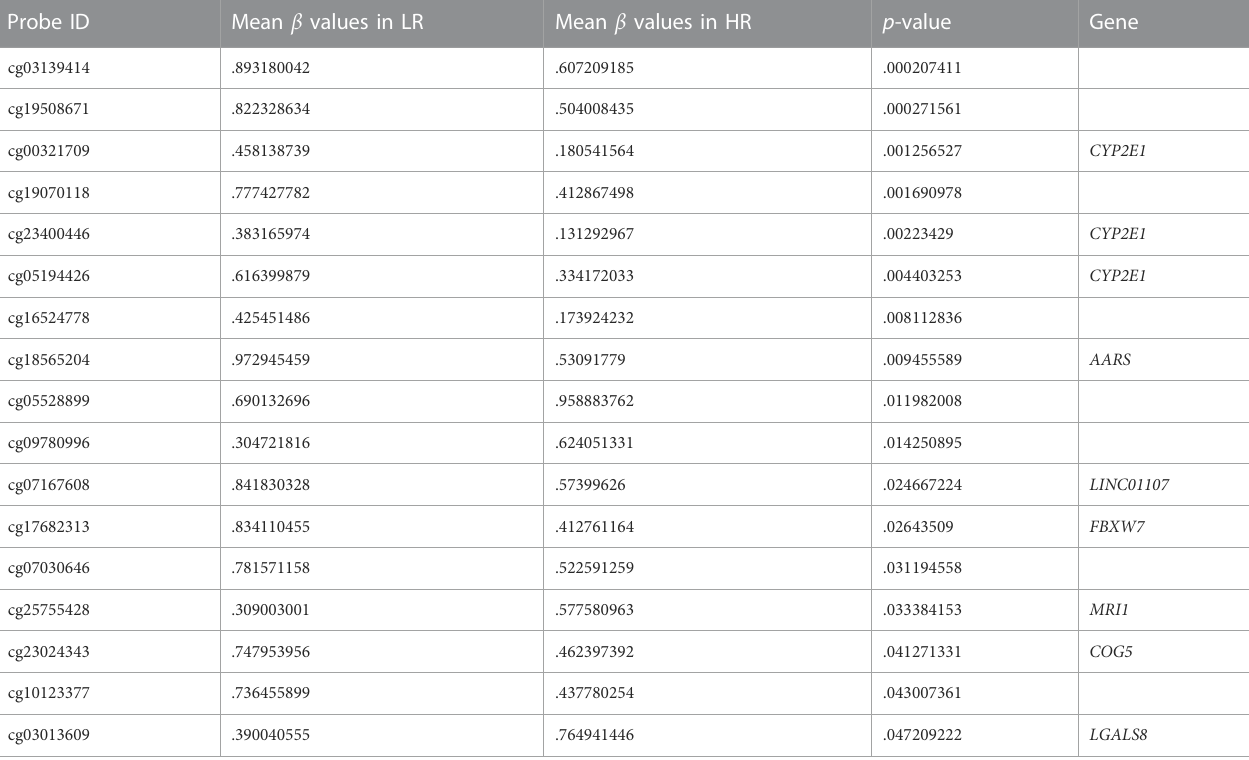
TABLE 2 Genome-wide DNA methylation probe levels in the LR and HR groups of the discovery set a . Probe